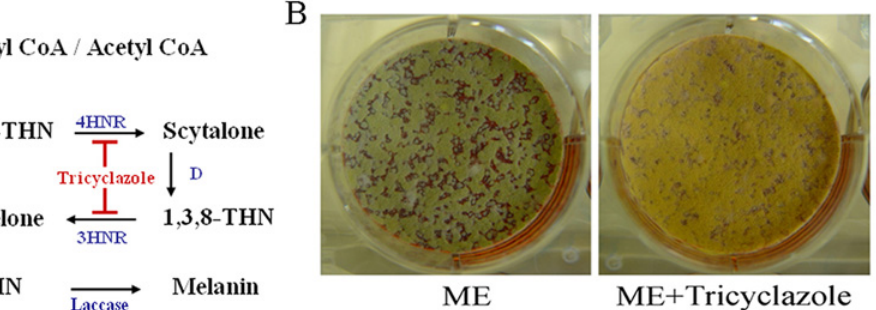
Fig 1. The effect of tricyclazole on melanization during asexual development. (A) The generic DHN melanin biosynthetic pathway [15, 24, 43]. Enzymes acting at each step include polyketide synthase (PKS), tetrahydroxynaphthalene reductase (4HNR), trihydroxynaphthalene reductase (3HNR), dehydratase (D), and laccase. Intermediate metabolites including 1,3,6,8-tetrahydroxynaphthalene (1,3,6,8-THN), scytalone, 1,3,8-trihydroxynaphthalene (1,3,8-THN), vermelone, and 1,8-dihydroxynaphthalene (1,8-DHN). (B) At 28°C, T . marneffei F4 colonies appear green as a result of the pigmented conidia. The addition of 30 μ g/ml tricyclazole, which inhibits two reductases (4HNR and 3HNR) functioning during DHN melanin synthesis, results in yellow